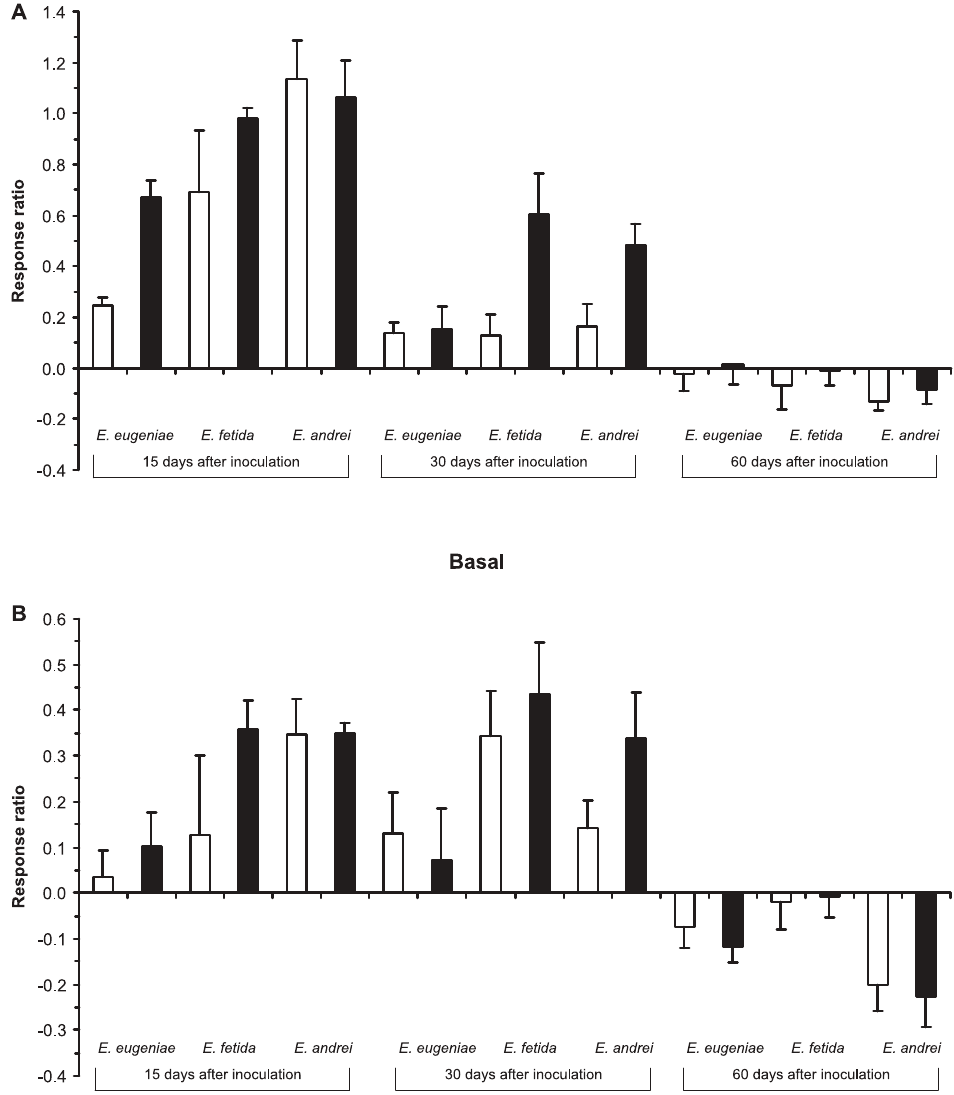
Figure 1. Effects of type of vermicompost, dose of inoculation and time on microbial biomass and activity. Shown are the changes in the a) substrate induced respiration and b) basal respiration in presence of inoculum of vermicompost (2.5 and 10%) relative to control (no inoculum) calculated as (V i -V c )/V c , where V i and V c are the values of the variables of samples inoculated with vermicompost or controls. White and black bars represent 2.5 and 10% of inoculation respectively. Mean 6 SE (n=5).